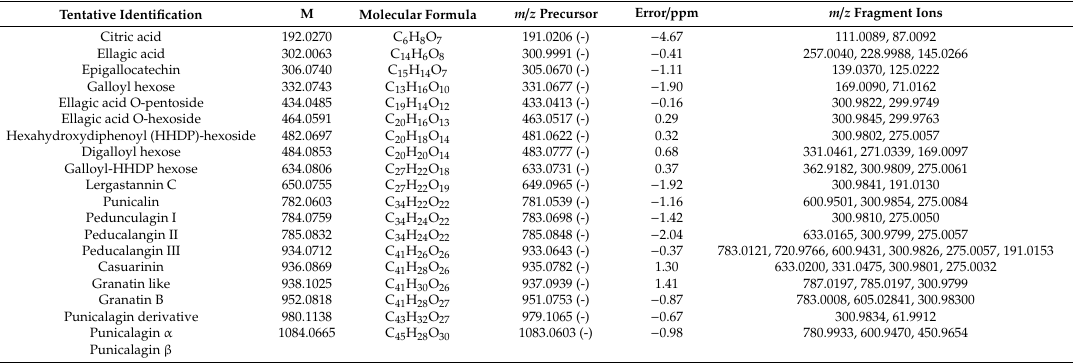
Table 1. Compounds characteristic for ethanol pomegranate ( Punica granatum L.) peel extracts. The table presents the experimental monoisotopic mass of the identified compound (M), molecular formula, precursor ion m / z , mass error (ppm) and fragment ions m / z .